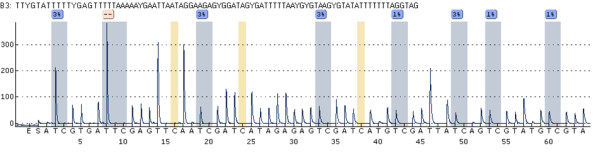
MLH1 region 1 pyrogram. MLH1-1 assay showing seven analyzed sites (sample P44 T0). CpG number 2 was not considered for analysis. Three bisulfite treatment controls (16, 24, 38) confirm the complete conversion of unmethylated (non-CpG motif) cytosine residues.